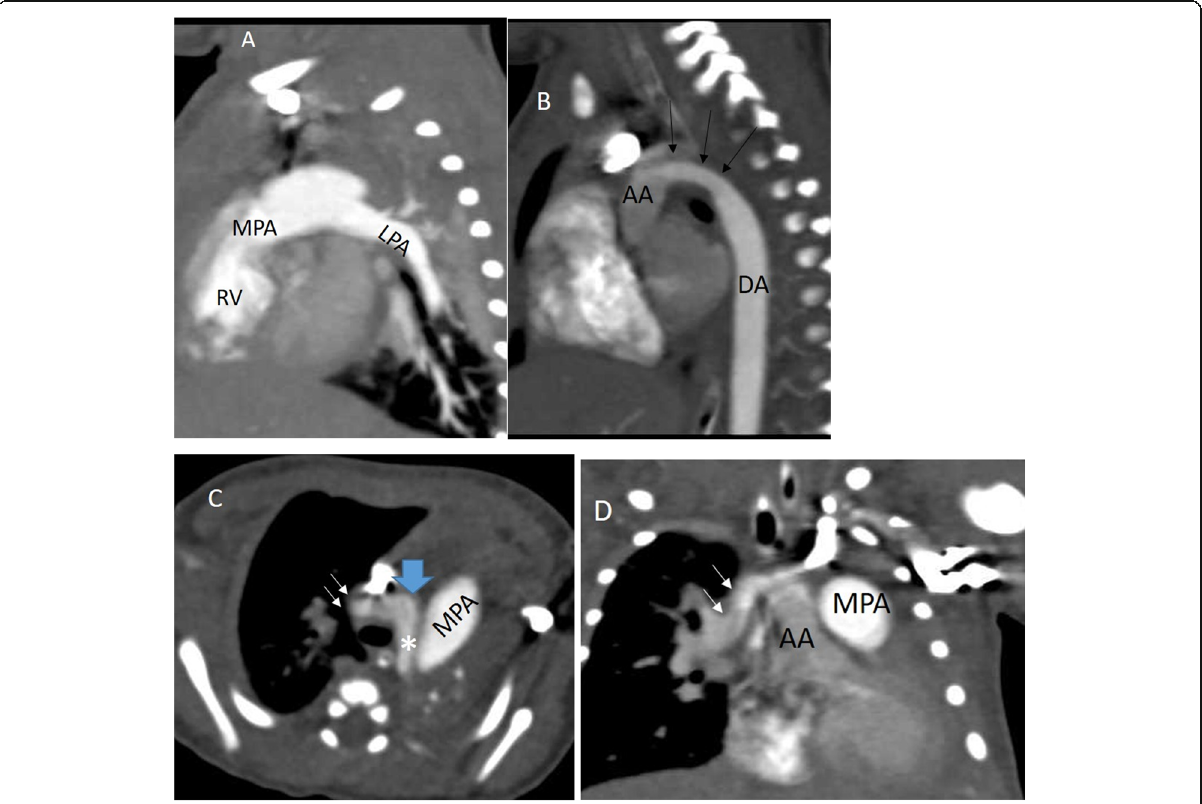
Fig. 5 A 2-week-old baby with anomalous origin of right pulmonary artery form aorta. a Sagittal CTA: dilated MPA and LPA. b Sagittal CTA: hypoplastic aortic arch (arrows) . c Axial CTA shows hypoplastic aortic arch (*) and anomalous origin of RPA (arrows) from the cephalic part of ascending aorta (AA) (blue block arrow). d Coronal CTA: the RPA (arrows) arises from the cephalic part of